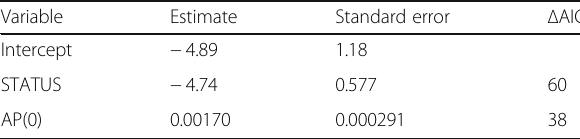
Table 2 Parameter estimates for the variables in the final fitted model, their standard errors, and Δ AIC. Δ AIC is the increase in AIC when the variable is removed from the model and is an indicator of the importance of the